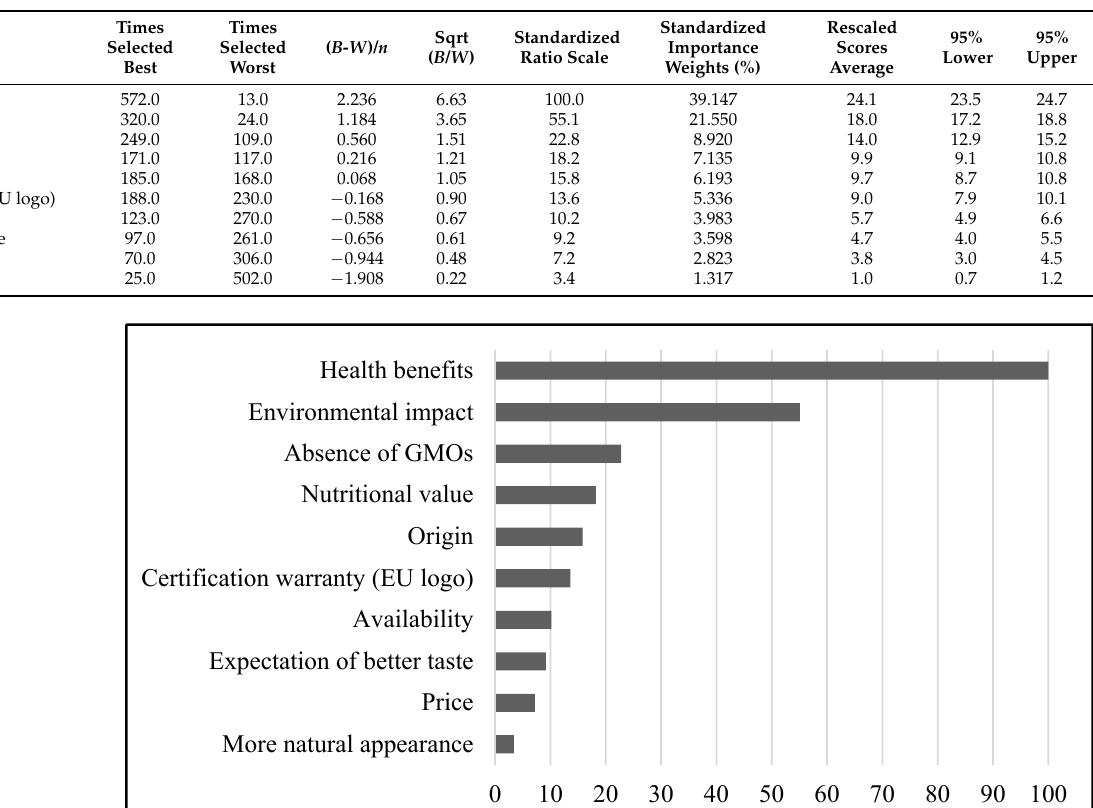
Table 2. Raw best-worst, average best-worst, and standardized aggregated importance weights.